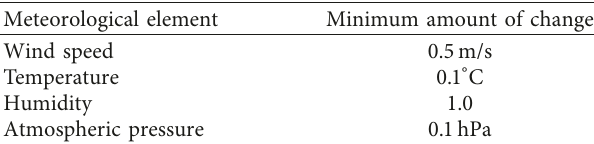
Table 4: Minimum amount of change for persistence